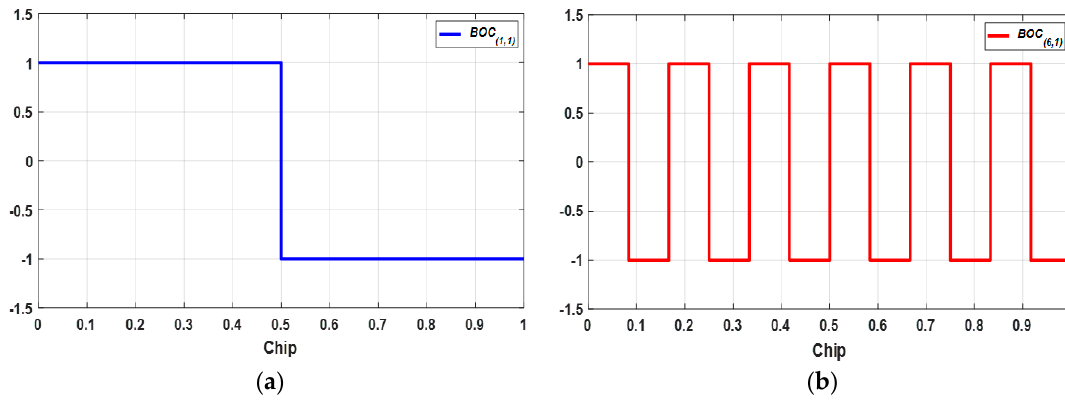
Figure 2. BOC modulation; ( a ) BOC (1,1) ; ( b ) BOC (6,1) .